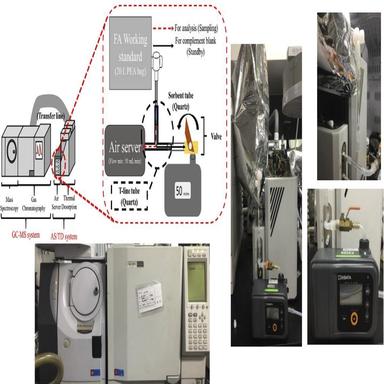
Schematic of AS/TD-GC/MS system for the analysis of lower FA concentrations (0.1–0.5 ppm).